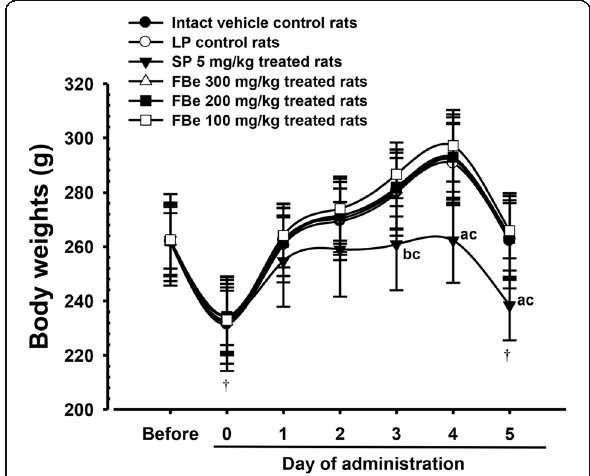
Fig. 2 Body weight changes in the constipation rats induced by LP. Values are expressed mean ± SD of eight rats, g. FBe: Triple fermented barley extracts, test material; SP: Sodium picosulfate; LP: Loperamid. All animals were overnight fasted before fist and last sixth test material administration ( † ). Before means 1 day initiation of administration and 0 means at initiation of administration. a p < 0.01 and b p < 0.05 as compared with intact control by